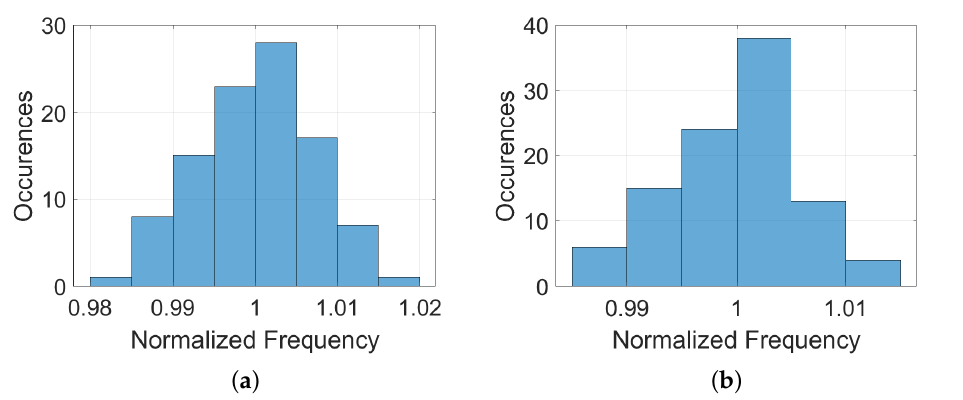
Figure 16. Histogram of the ( a ) lower cut-off frequency and ( b ) center frequency of the notch band- stop filter of the last stage of circuit 2. Both frequencies are normalized with respect to the mean of all 100 Monte Carlo samples of each respective